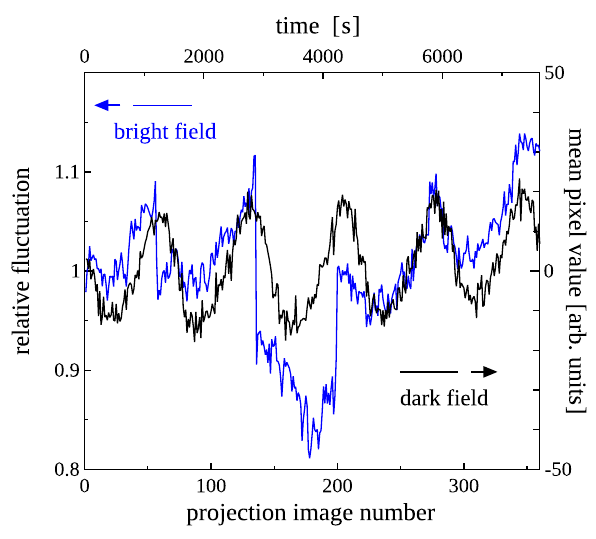
FIG. 5. The fluctuations of image pixel values during the CT measurement as functions of the projection image number or time. The mean values of the pixel values in the dark field corresponding to the rectangle of the dashed yellow line in Fig. 4 are plotted with the black line. The blue line indicates the fluctuation of the mean value in the bright field (the dashed blue rectangle in Fig. 4) relative to the average overall projection